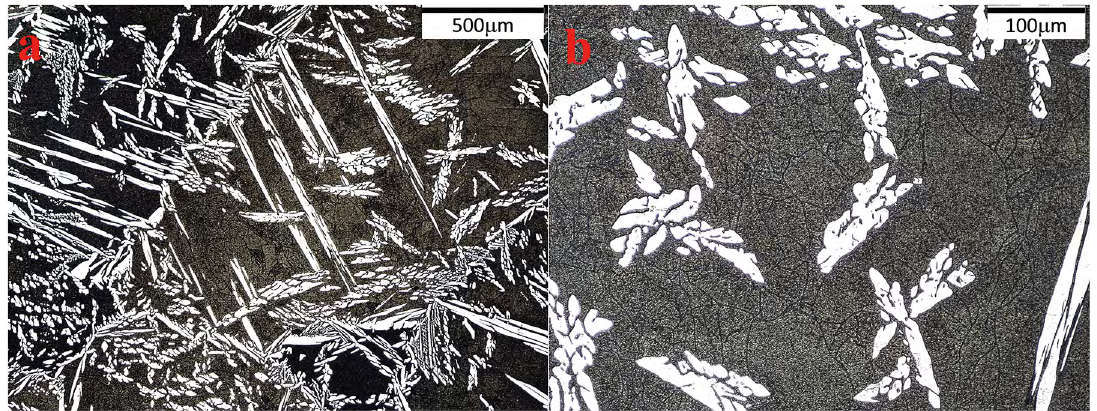
Figure 7. Micrographs of D5 condition (a) OM-50x; (b) clusters of intragranular austenite - OM-200x. Behara II.